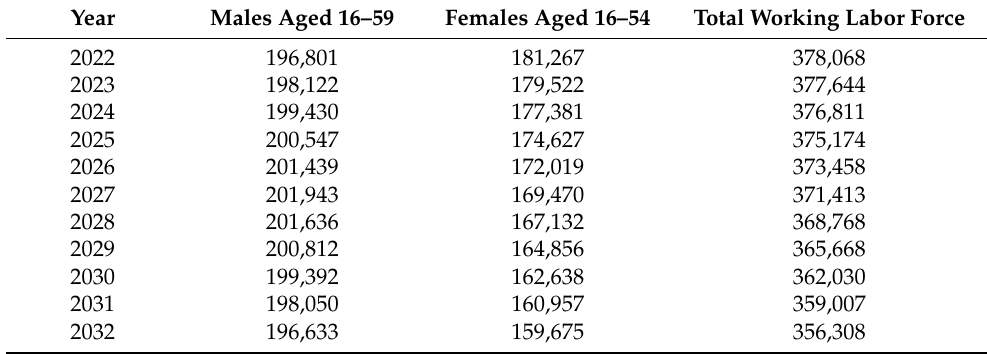
Table 1. The sizes of the male and female labor forces in Anhui Province from 2022 to 2032 (unit: person).